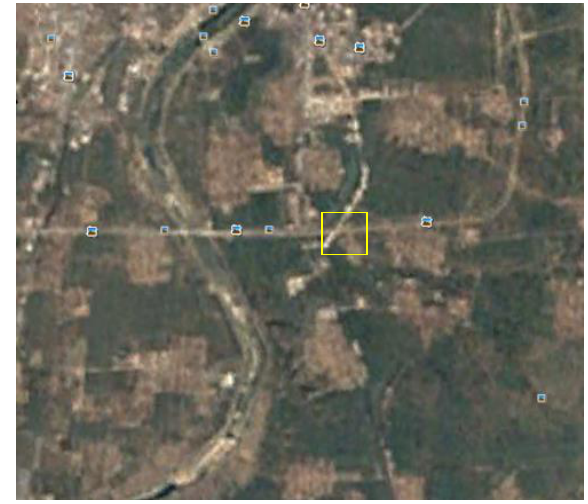
Figure 9. Available Google Earth image 2012 for S1.